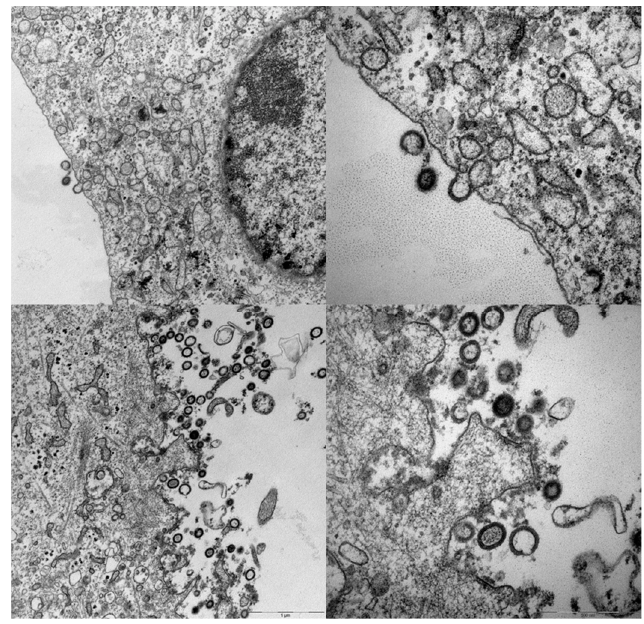
Figure 3. Secretion of VLPs from vector transduced cells. Vero cells infected with VLVs, then fixed, embedded, sectioned, and stained for transmission electron microscopy. The right-side micrographs depict higher magnification of the overview images to the left. The scale bar is visible at the lower right of the bottom micrographs. Specific experimental conditions were as described in Andersson et al. 2016 [7].